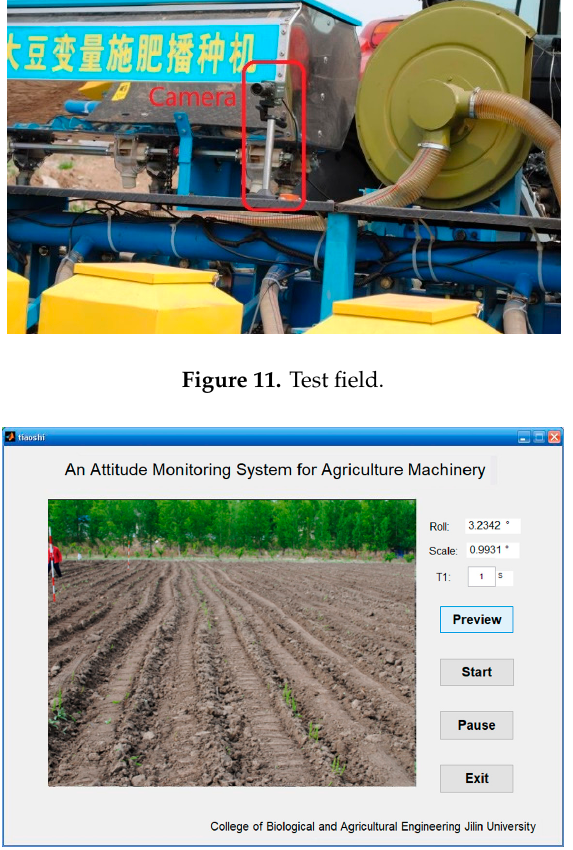
Table 1. The field test result.